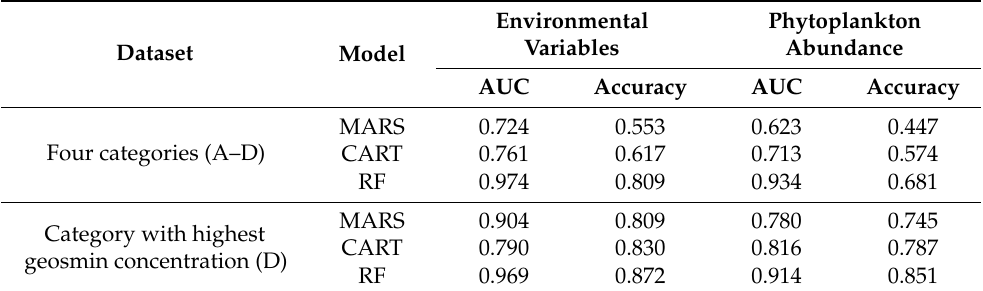
Table 4. Comparison of the predictive performance of three different models with different combi- nations of independent variables (environmental variables and phytoplankton abundance). CART: classification and regression tree, MARS: multivariate adaptive regression splines, and RF: random forest. Categories (A–D) of geosmin concentration are given in Table 3.